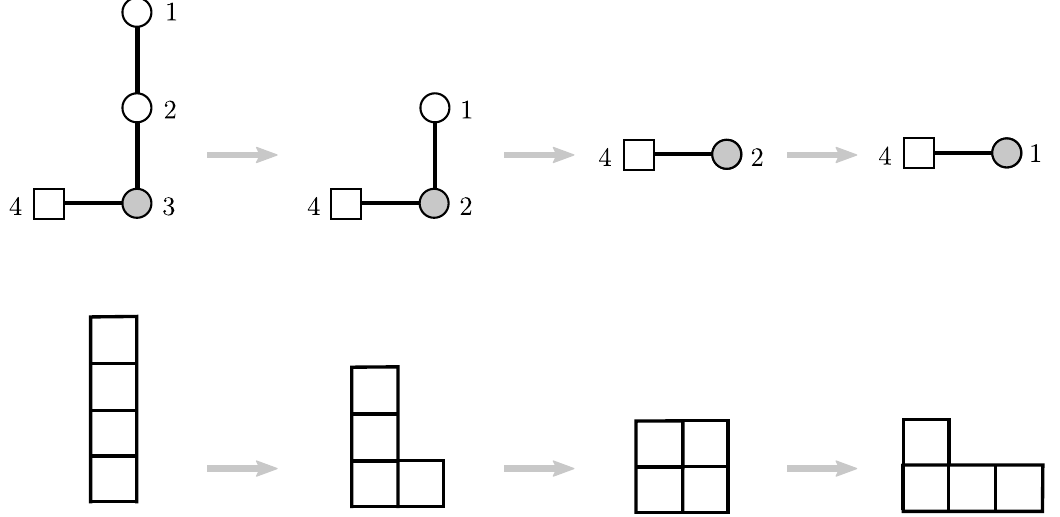
Figure 8: Coulomb branch Higgsing for A